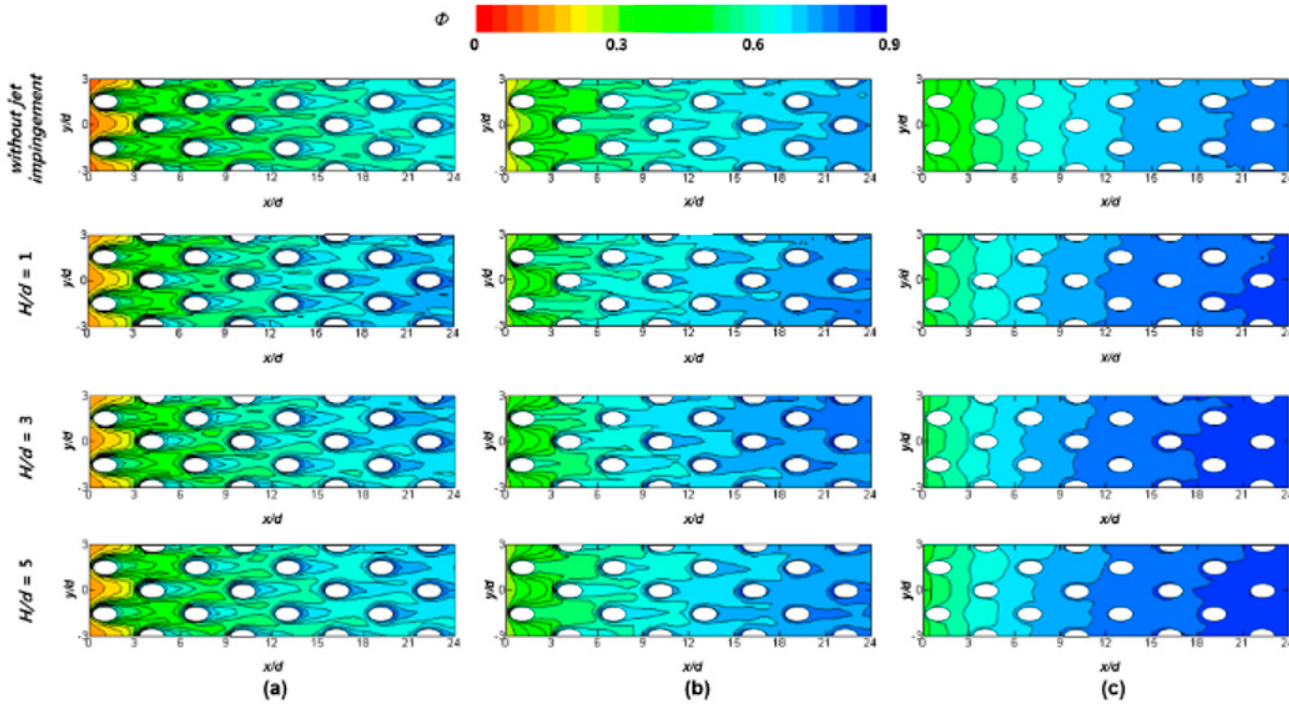
Figure 11. Total cooling effectiveness in a full-coverage film cooling with changing conductivity of the base plate in a flat plate configuration [56]. Thermal conductivities were ( a ) 0.2, ( b ) 1, and ( c ) 13.4 W/mK. As the conductivity increases, film streaks get blurred. ( c ) 13.4 W/mK. As the conductivity increases, film streaks get